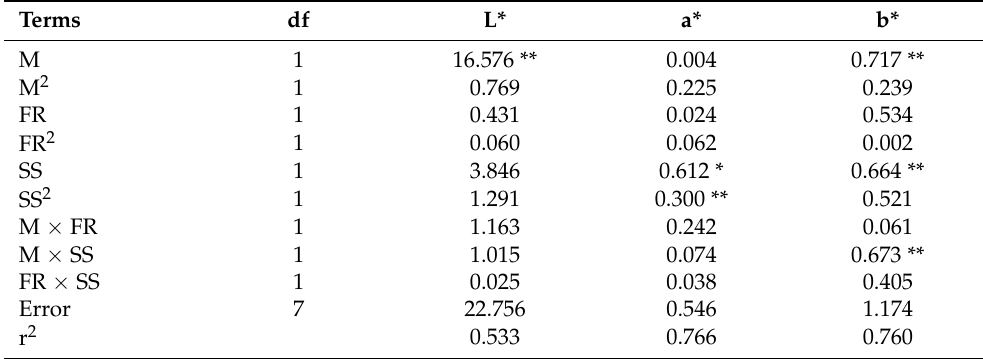
Table 4. Analysis of variance for second-order polynomial for color parameter